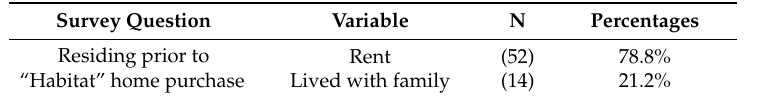
Table 10. Responses to the question ‘Before buying your Habitat home, please indicate your residence.